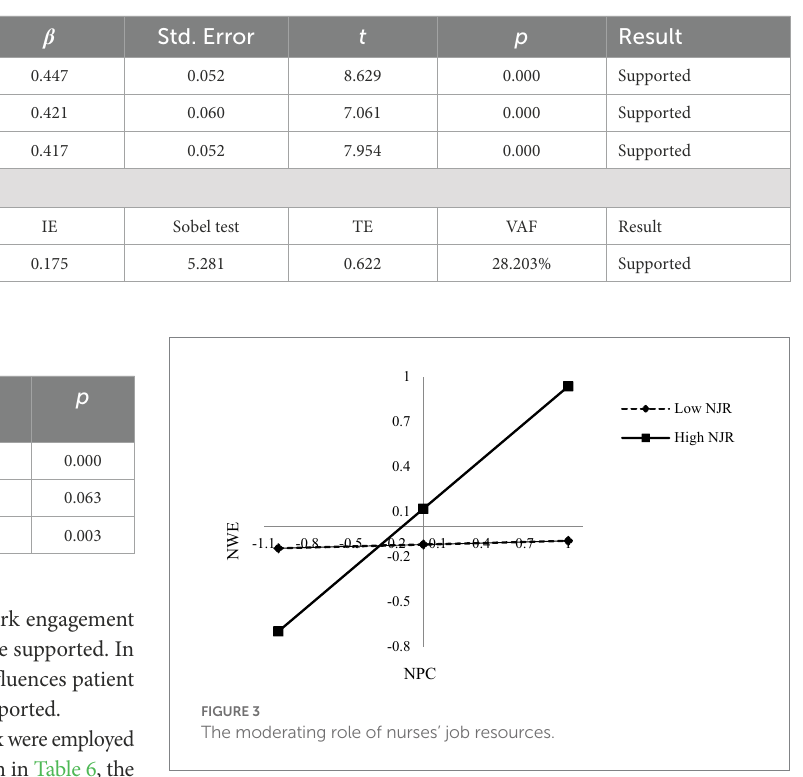
TABLE 6 The mediating effect test results.